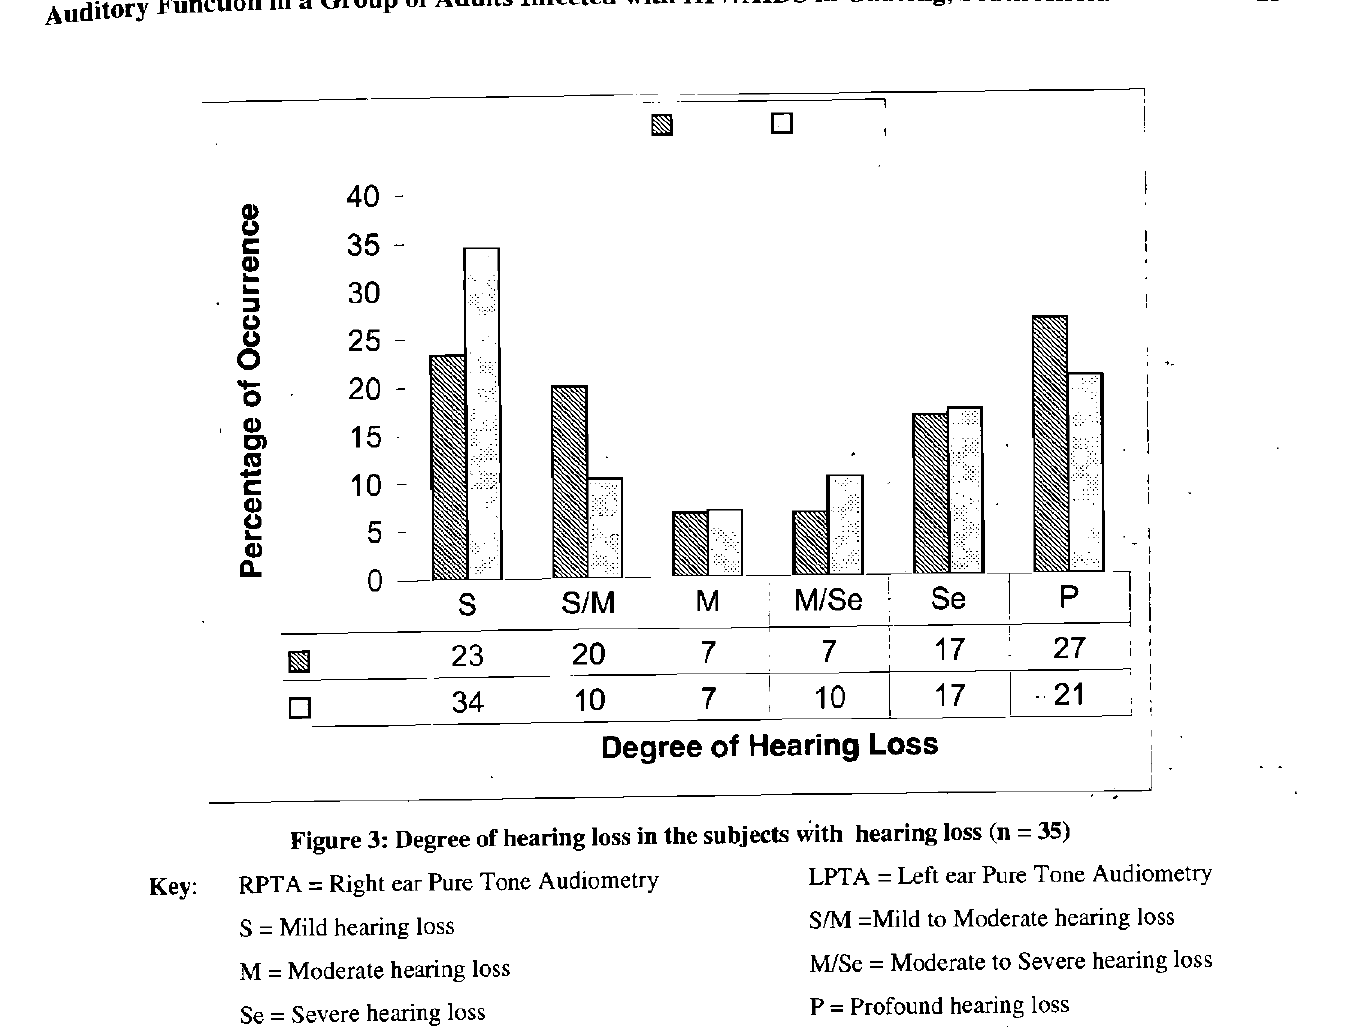
Figure 3: Degree of hearing loss in the subjects with hearing loss (n =